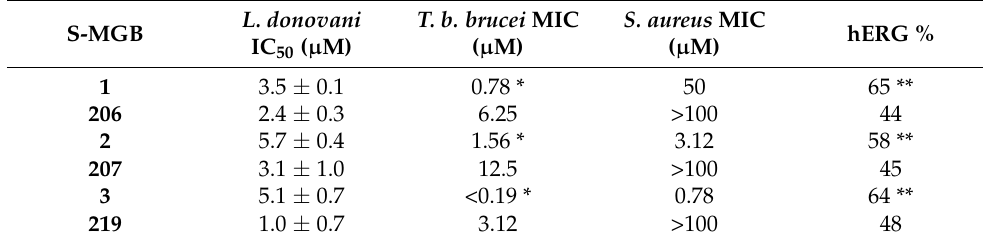
Table 1. Biological evaluation of S-MGBs against L. donovani , T. b. brucei and S. aureus . Inhibition of hERG ion channel: compounds were assessed at 10 µ M and % displacement of [3H]-astemizole is reported. Each assay was run in triplicate and 3 separate experiments were carried out ( n = 3). * data previously reported [19]. ** Data previously reported [20].